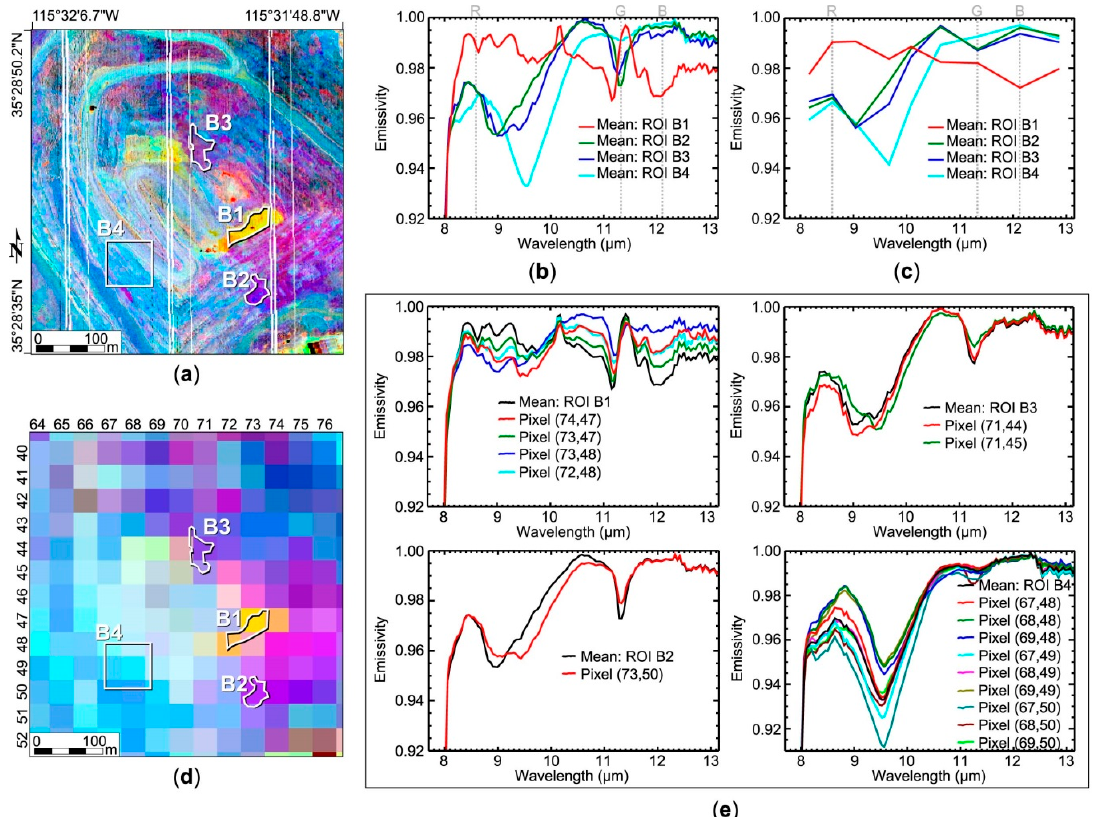
Figure 19. Detailed examination of a subset of the Mako emissivity data: ( a ) outlines of selected regions of interest (ROIs) on the false color composite image with bands 8.59/11.32/12.10 µm displayed as red/green/blue; ( b ) mean emissivity spectra of the ROIs; ( c ) mean emissivity spectra of the ROIs convolved to the spectral response functions of the MODIS/ASTER Airborne Simulator (MASTER) longwave infrared bands; ( d ) ROI outlines on Mako data resampled to the pixel size of our MASTER data set; ( e ) mean emissivity spectrum of each ROI plotted with the spectra of the new resampled pixels to which it contributes.